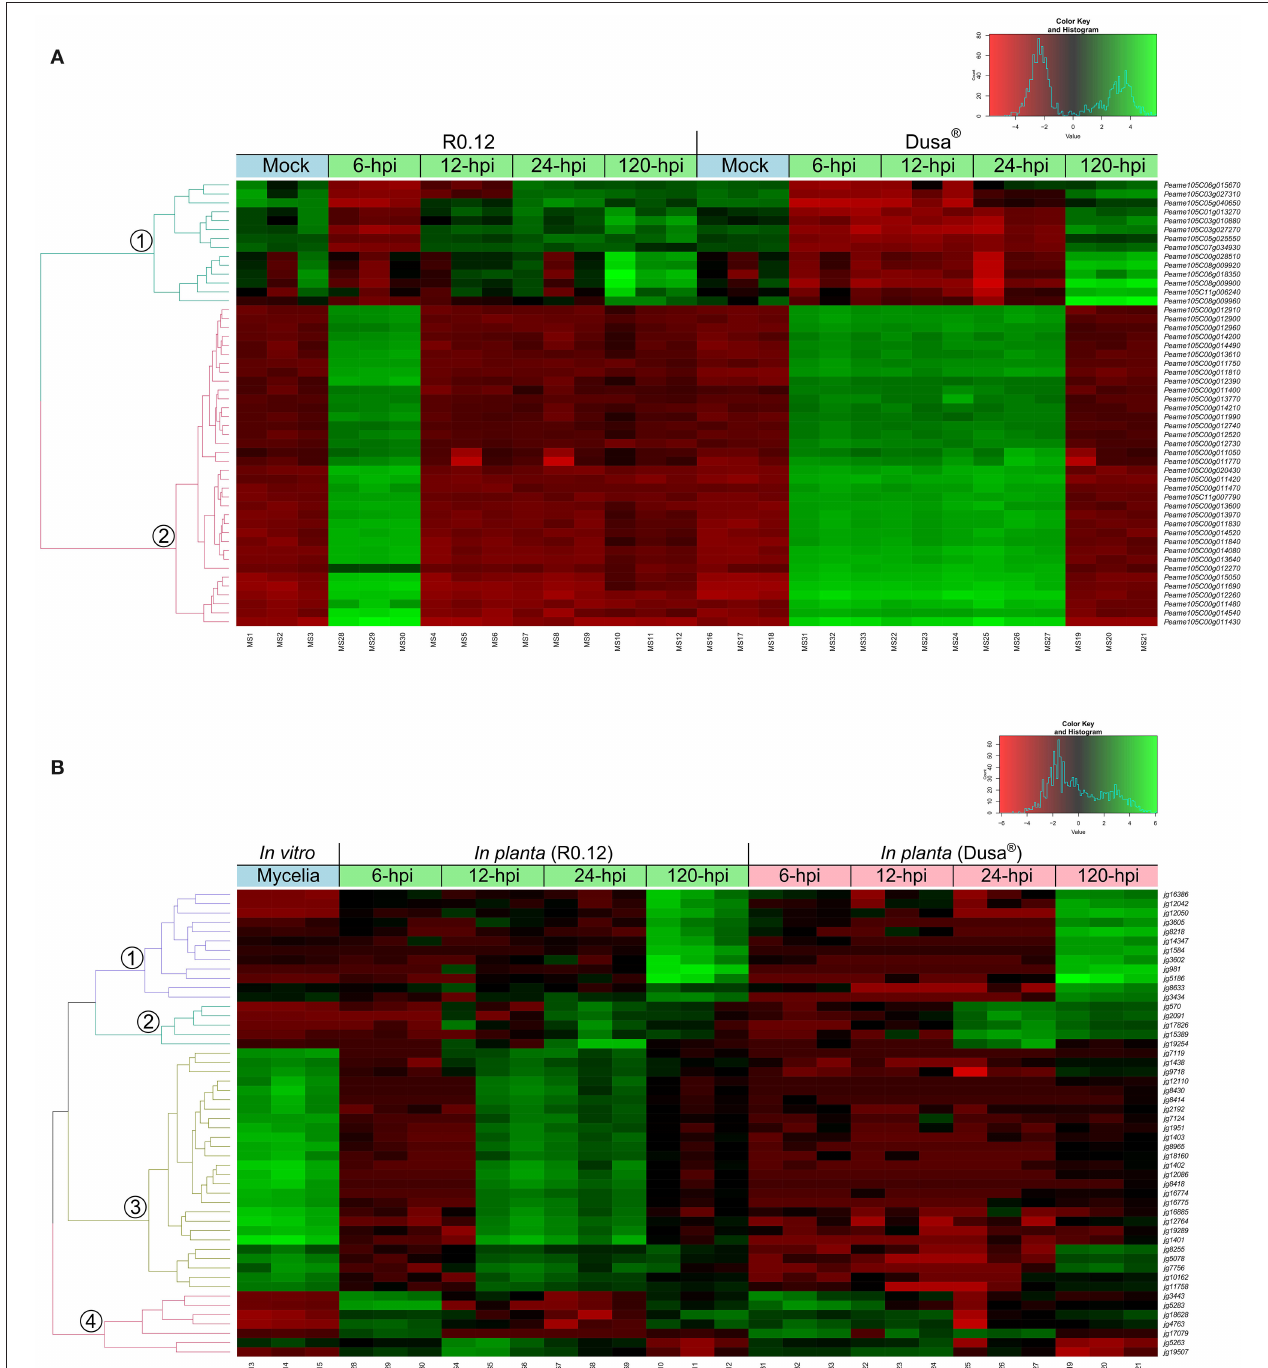
FIGURE 3 | Hierarchical clustering of the top 50 variably expressed Persea americana and Phytophthora cinnamomi genes. Expression values were obtained following differential gene expression analyses and variance stabilized transformation. The green color represents upregulation, while red indicates downregulation, the scale of which is indicated by the intensity of the color. Gene identifiers are located on the right of the heatmap. Dual RNA-seq library references are indicated along the bottom of the heatmap. Sample clustering is represented by a dendrogram on the left of the heatmap that is color-coded and labeled accordingly. (A) Top 50 variably expressed P. americana genes across all samples were visualized by hierarchical clustering. Samples include both partially resistant (Dusa ® ) and susceptible (R0.12) P. americana rootstocks that were either mock-inoculated (dH 2 O) or inoculated with P. cinnamomi and harvested at 6, 12, 24, or 120h post inoculation (hpi), indicated along the top of the heatmap. (B) Top 50 variably expressed P. cinnamomi genes across all samples were visualized by hierarchical clustering. The green color represents upregulation, while red indicates downregulation, the scale of which is indicated by the intensity of the color. Samples include in vitro P. cinnamomi mycelial controls and in planta samples, partially resistant (Dusa ® ) and susceptible (R0.12) P. americana rootstocks that were inoculated with P. cinnamomi and harvested at 6, 12, 24, or 120h post inoculation (hpi), indicated along the top of the heatmap.